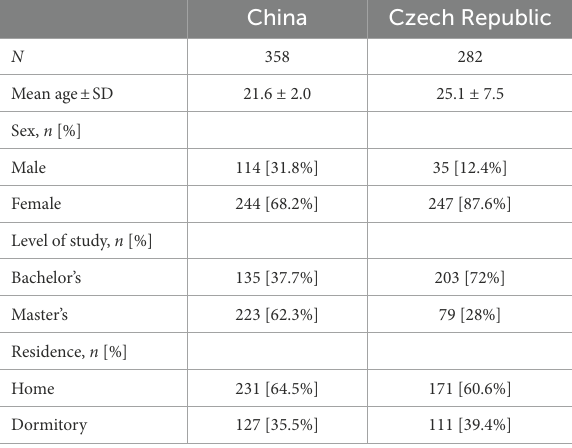
TABLE 1 Main characteristics of the research